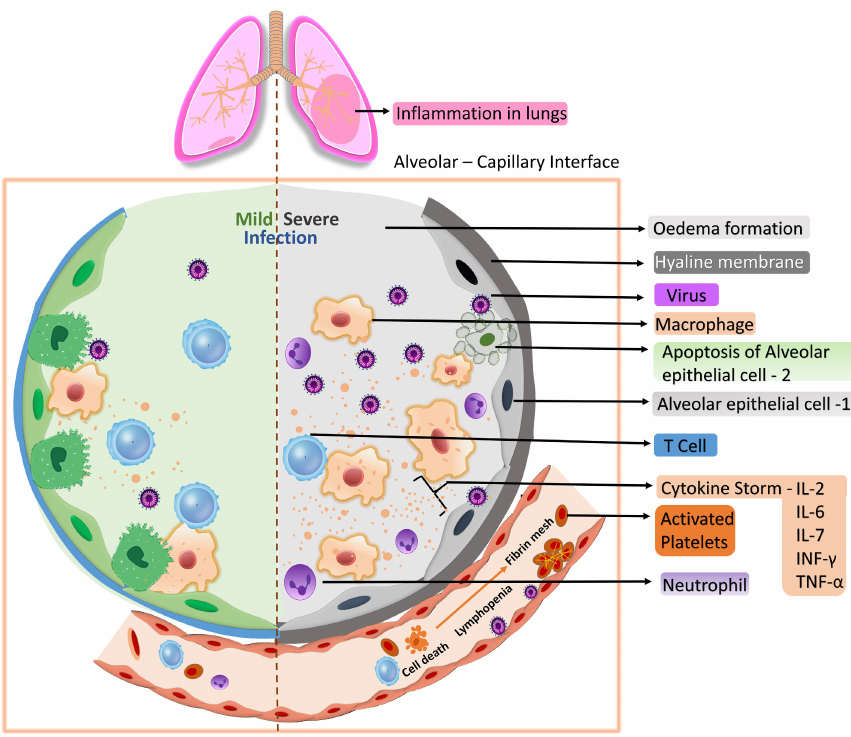
Figure 2. Pathogenesis of SARS-CoV2 virus in host respiratory system. SARS-CoV2, severe acute respiratory syndrome coronavirus